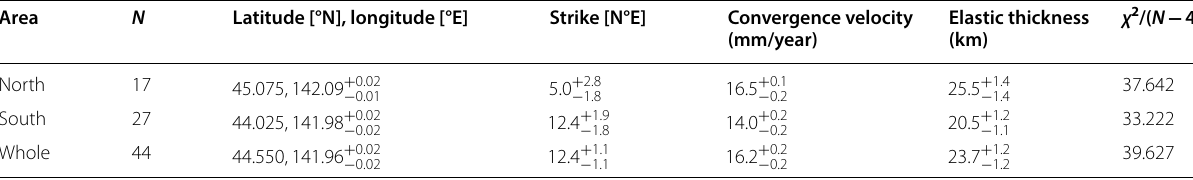
N is the number of stations in each area. Latitude [°N] and longitude [°E] represent the fix points of the boundary. Strike [N°E] is the angle of the boundary from north to east. Errors of each parameter are shown as 2 σ